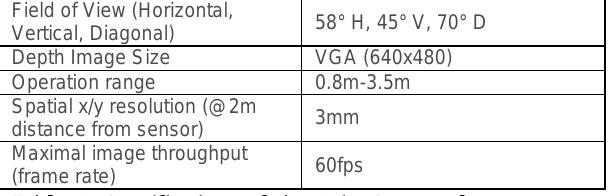
Table 1. Specifications of the PrimeSense reference sensor design as given by the